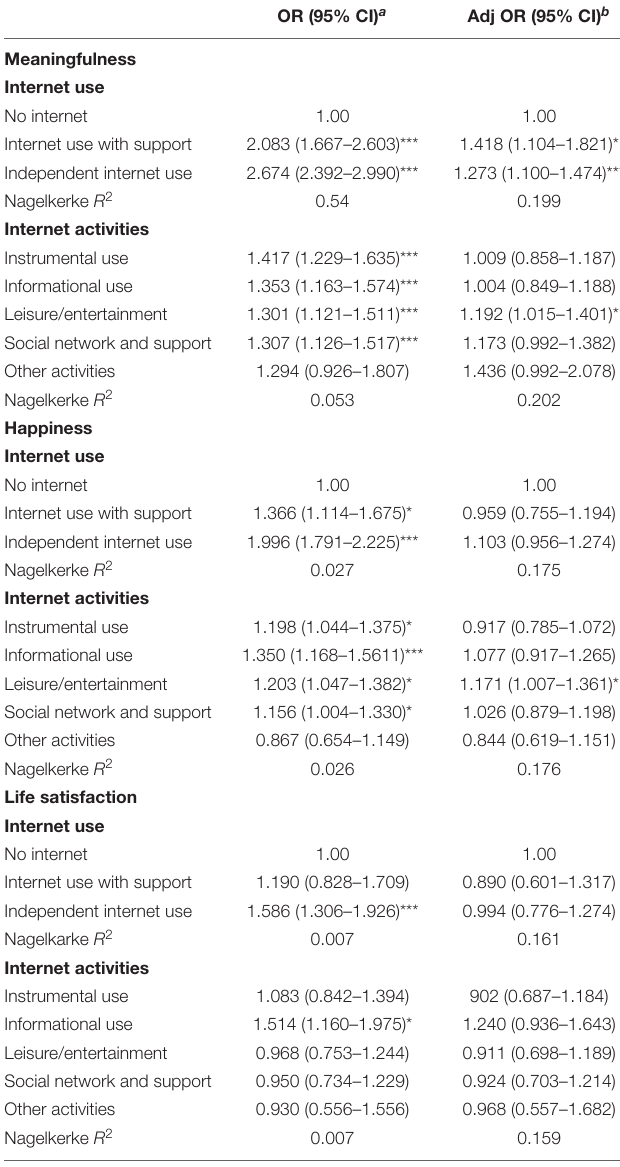
TABLE 4 | Odds ratio and their 95% confidence intervals of perceived meaningfulness, happiness and life satisfaction as well as the results from Nagelkarke R 2